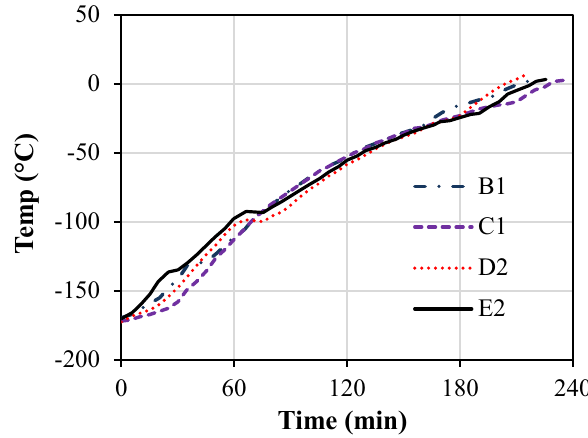
Fig. 2 Temperature versus time relationship during heating